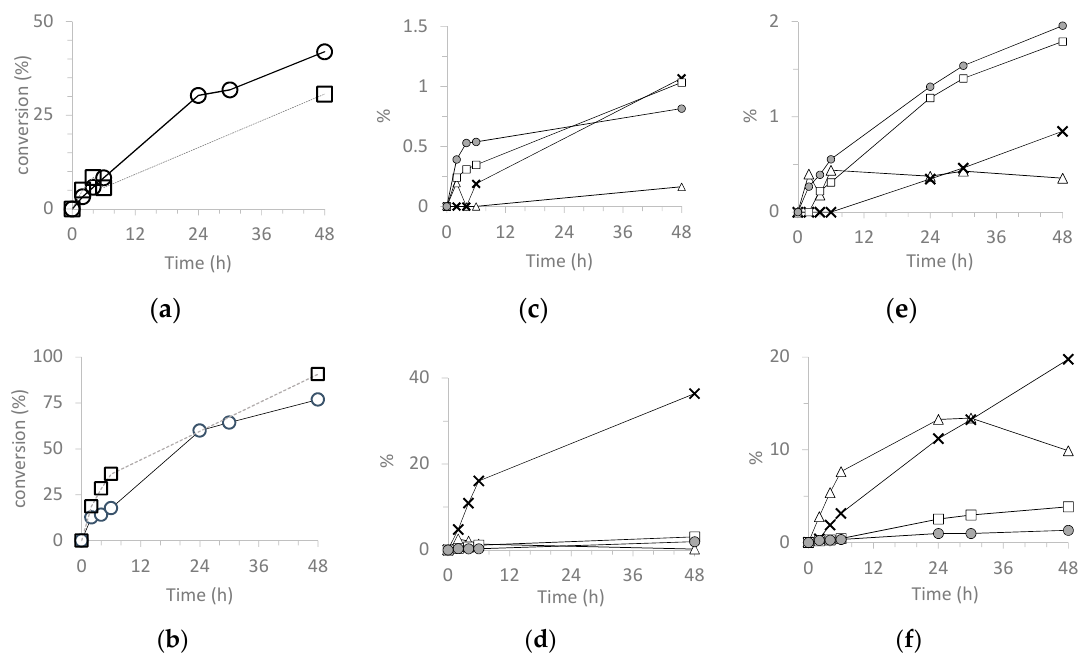
Figure 7. Comparison of conversion of CH between ( a ) H 3 PW 12 O 40 ( □ ) and SiO 2 @PW (  ), ( b ) H 3 PMo 12 O 40 ( □ ) and SiO 2 @PMo (  ). Evolution of CHO (  ), CHD ( × ), CHol ( □ ) and CHone ( ● ) with ( c ) H 3 PW 12 O 40 , ( d ) H 3 PMo 12 O 40 , ( e ) SiO 2 @PW (Run 1) and ( f ) SiO 2 @PMo (Run 1).